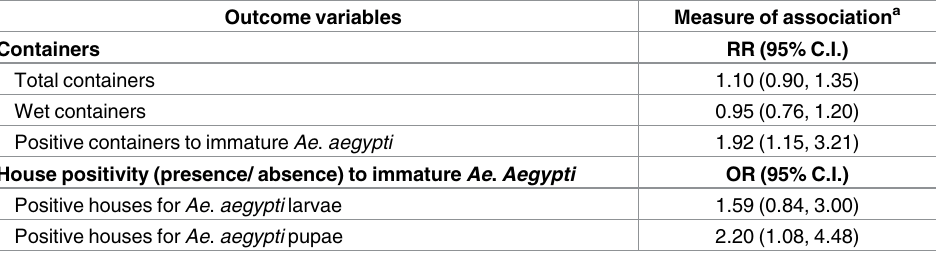
Table 4. Association between entomologic risk in backyardsand outdoor spatial spraying